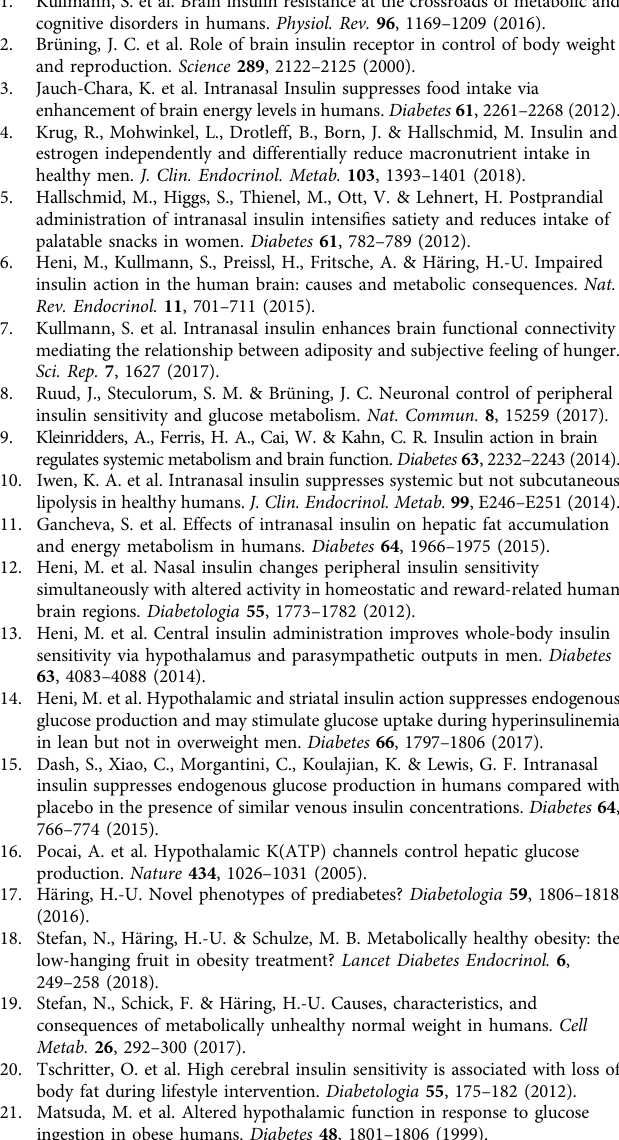
Determination of body fat distribution by MRI . Whole-body MRI was per- formed in the early morning after overnight fasting on a 1.5T whole-body imager (Magnetom Sonata, Siemens Healthcare, Erlangen, Germany). A T1-weighted fast- spin-echo technique (echo-time TE = 12 ms, repetition time TR = 490 ms) was applied, acquiring axial images with a slice-thickness of 10mm and an interslice gap of 10mm. Depending on the size of the subject, 100 – 120 images were recorded from toes to fi ngers with subjects being in prone position with extended arms in a total measuring time of 20 – 25min. Detailed information is given in ref. 33 Seg- mentation and quanti fi cation of adipose tissue compartments was performed by an automated fuzzy-clustering algorithm with orthonormal snakes 34 . Visceral adipose tissue was in the abdominal cavity between femoral heads and thoracic diaphragm, subcutaneous adipose tissue along the body axis from feet to pelvis (available in N =